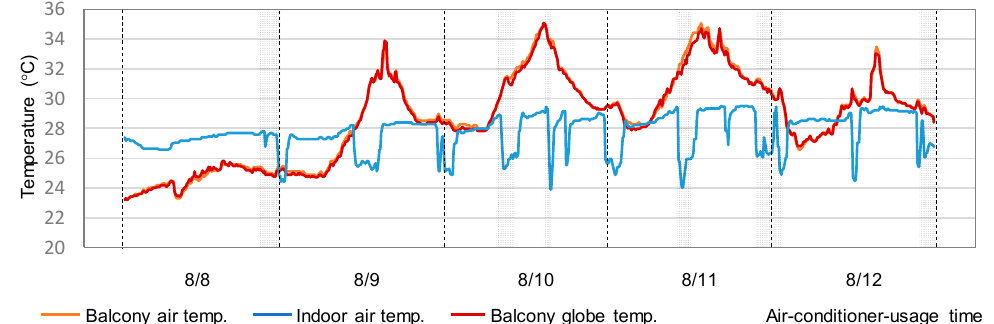
Figure 15. Variation of air temperature and air-conditioner-usage time.